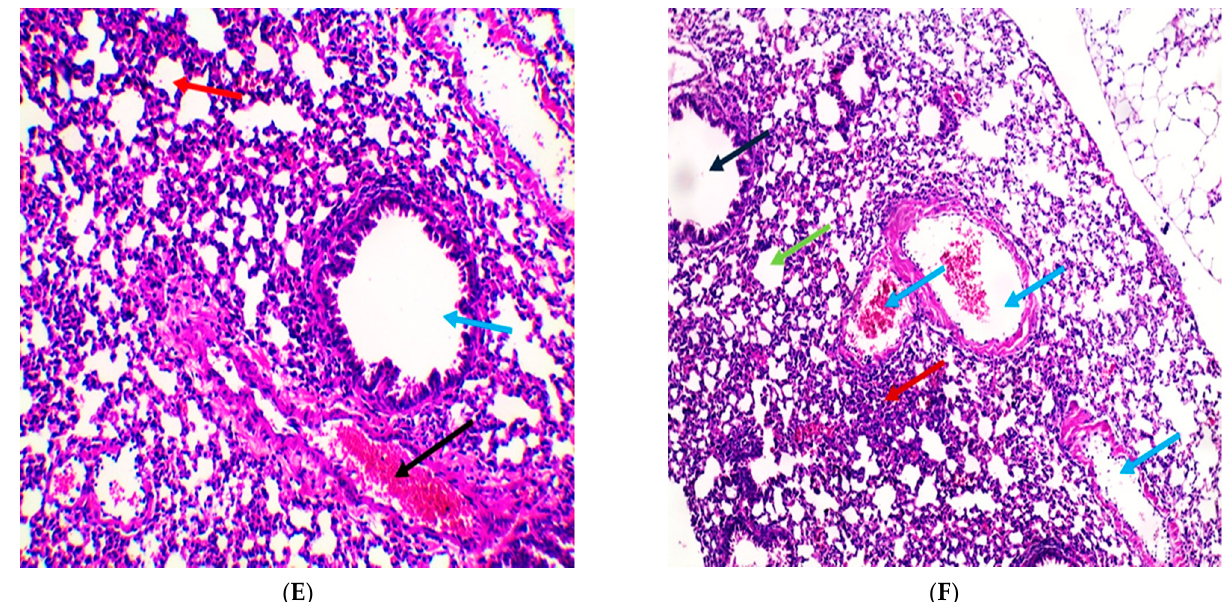
Figure 9. Histopathological examination of H&E-stained sections of lung tissue indicates the influence of APEE treatment on LPS-induced ALI. ( A ) A section in lung of the normal control group indicated normal-sized alveoli separated by fibrous septa (blue arrows) and normal-sized bronchiole (black arrow) (H&E X 100). ( B ) Section in lung of LPS group showed dilated bronchiole (blue arrow) surrounded by marked chronic inflammation and pneumonia (green arrow) and congested vessels (red arrow) (H&E X 200). ( C ) Section in lung of LPS group showed dilated destructed alveolar walls (emphysema) (red arrow) surrounded by destructed bronchioles (green arrow) and alveolar congestion with fibrosis (blue arrows) (H&E X 100). ( D ) Section in lung of APEE 200 treated group showed dilated bronchioles (red arrows) surrounded by decreased interstitial inflammation to moderate degree (blue arrows), congested vessels (green arrows) and decreased emphysema (black arrow) (H&E X 100). ( E ) Section in lung of APEE 250 treated group showed marked remission of inflammation with average-sized of a bronchiole (blue arrow) surrounded by normal-sized alveoli (red arrow) with few congested vessels (black arrow) (H&E X 200). ( F ) Section in lung of APEE 300 treated group showed focal inflammation (red arrow) surrounded by average-sized of a bronchiole (black arrow) surrounded by normal-sized alveoli (green arrow) with many congested vessels (blue arrows) (H&E X 100).